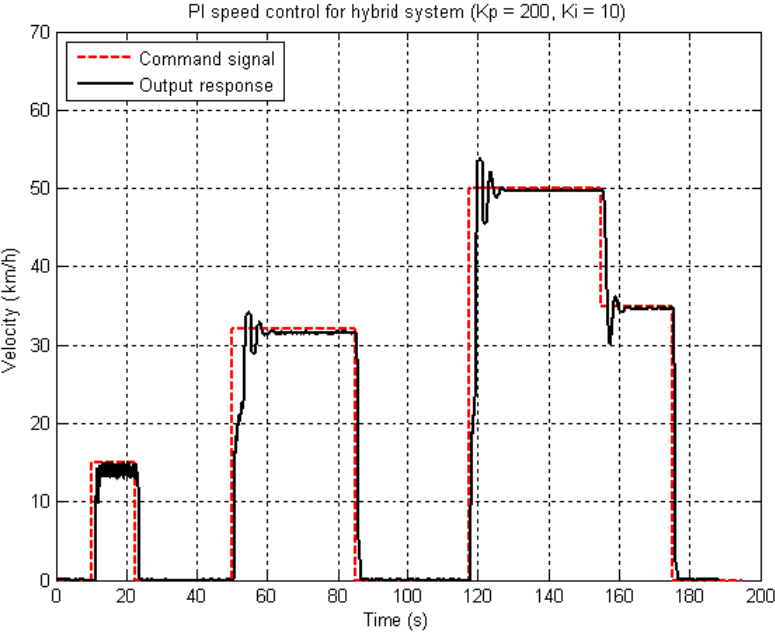
Figure 10. The ECE-40 driving cycle test under the hybrid mode.